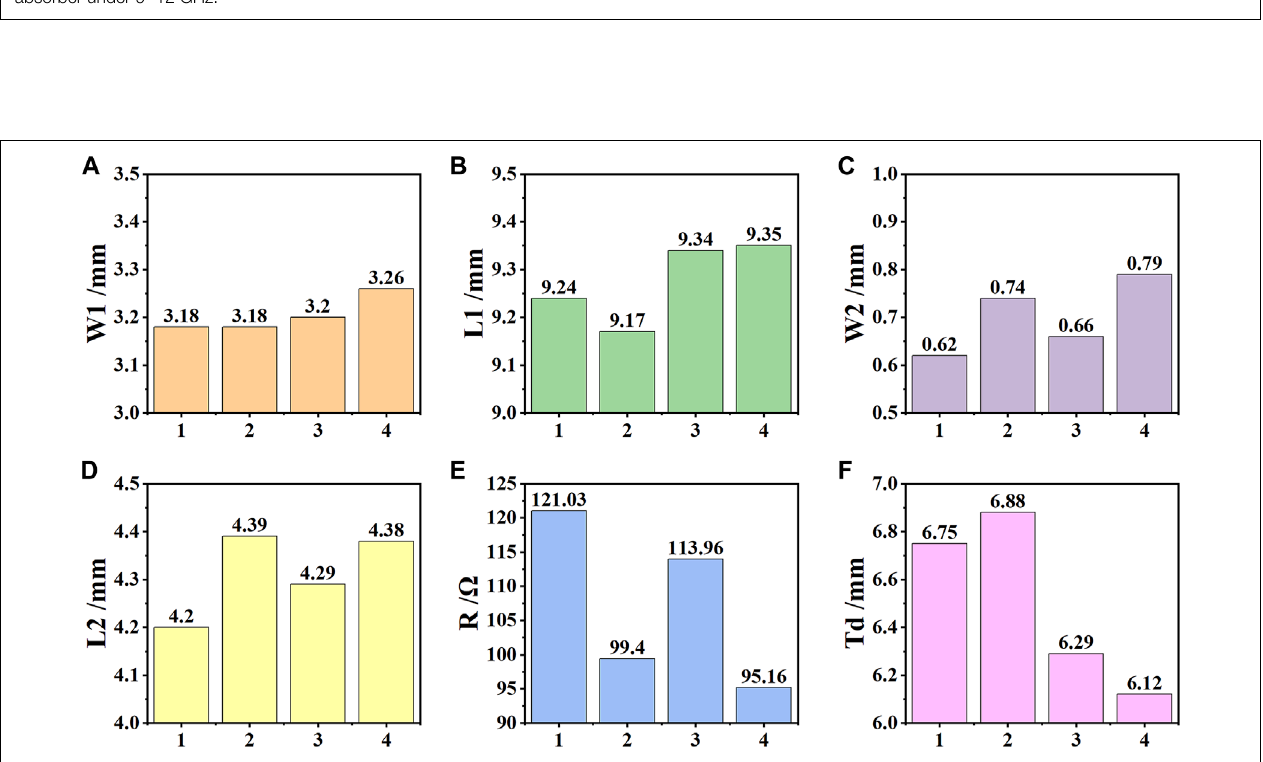
FIGURE 4 | Schematic diagram of a narrowband customized design. (A) The simulated results of the designed absorber under 5 ∼ 9 GHz. (B) The simulated results of the designed absorber under 6 ∼ 14 GHz. (C) The simulated results of the designed absorber under 5.5 ∼ 12 GHz. (D) The simulated results of the designed absorber under 9 ∼ 12 GHz.